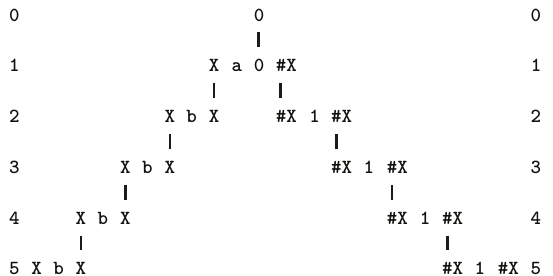
Figure 18: One of many SP-multiple-alignments produced by the SP Computer Model with a New SP-pattern, “ 0 ”, and a repository of user- supplied Old SP-patterns: “ X b X #X 1 #X ”. Reproduced with permission from Figure 4.4(a) in